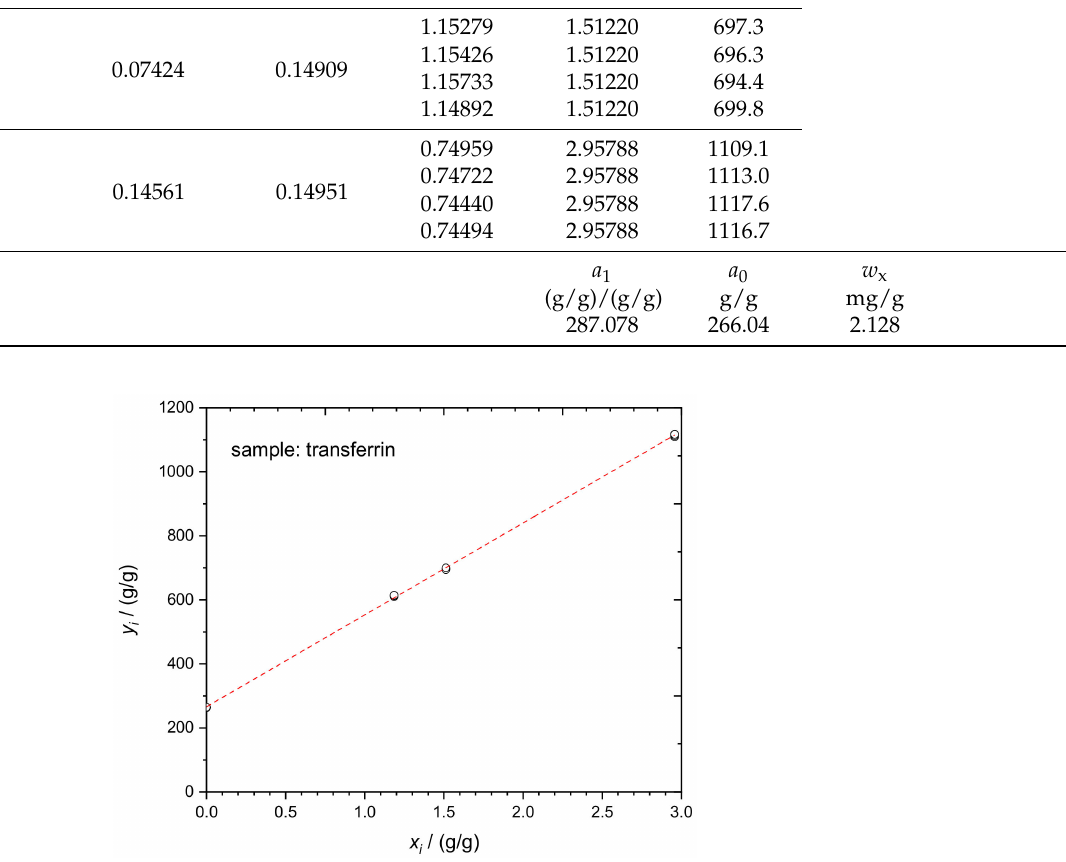
Figure 7. Linear regression evaluation of the TRF mass fraction in human serum according to Equation (2). Dataset in Table